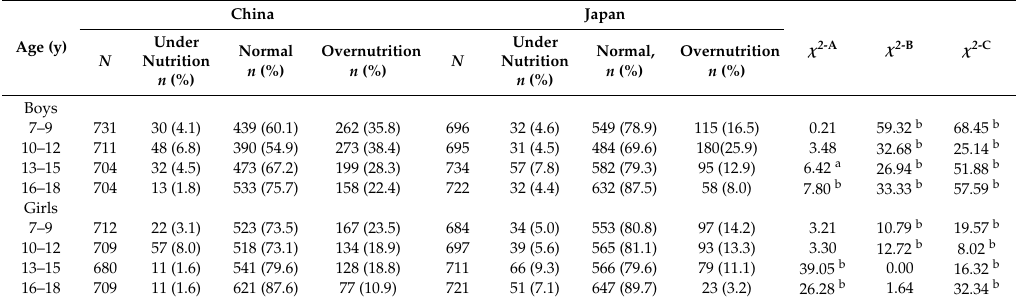
Under χ 2 -A χ 2 -B χ 2 -C Normal, Overnutrition Nutrition n (%) n (%) n (%)